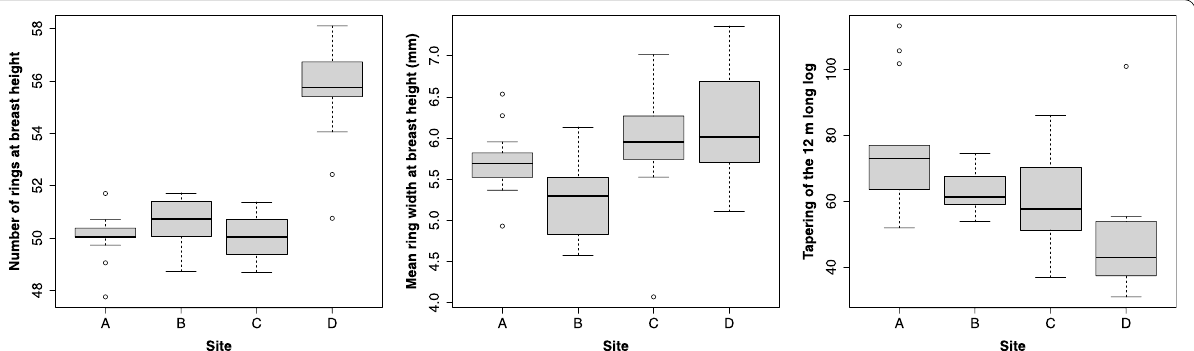
Fig. 1 Characteristics of the four stands with respect to some tree-level variables: the number of rings (on the left) and the mean ring width (in the middle) at breast height (i.e., at 1.30 m high), and the tapering of the long logs by using the variable slenderness12 (on the